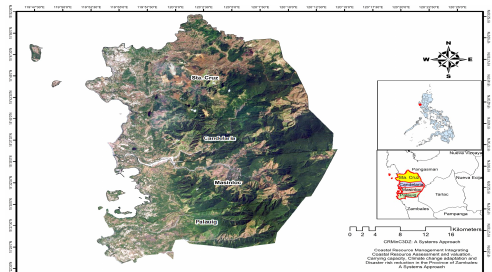
Figure 2. Satellite image of the study area